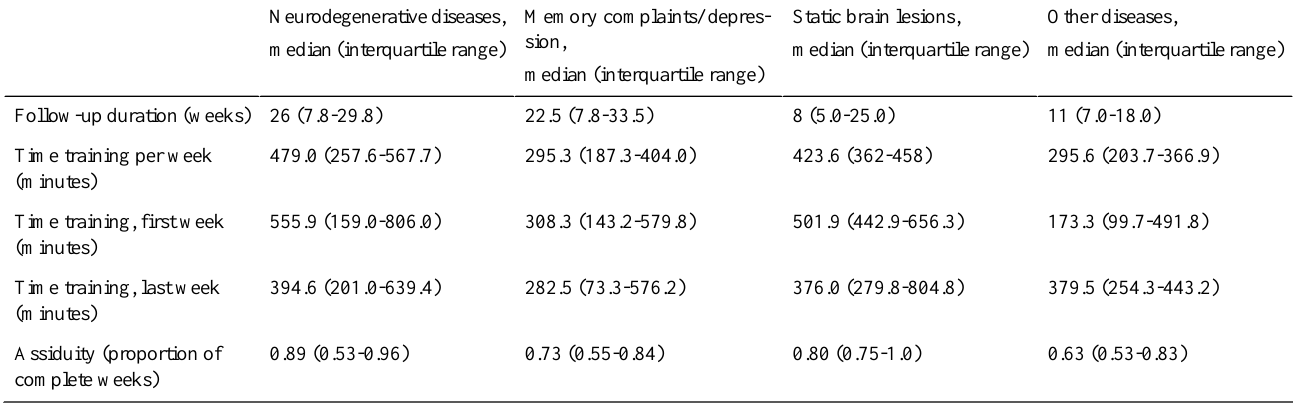
Table 2. Indicators of intensity and adherence to treatment per major group of diseases.